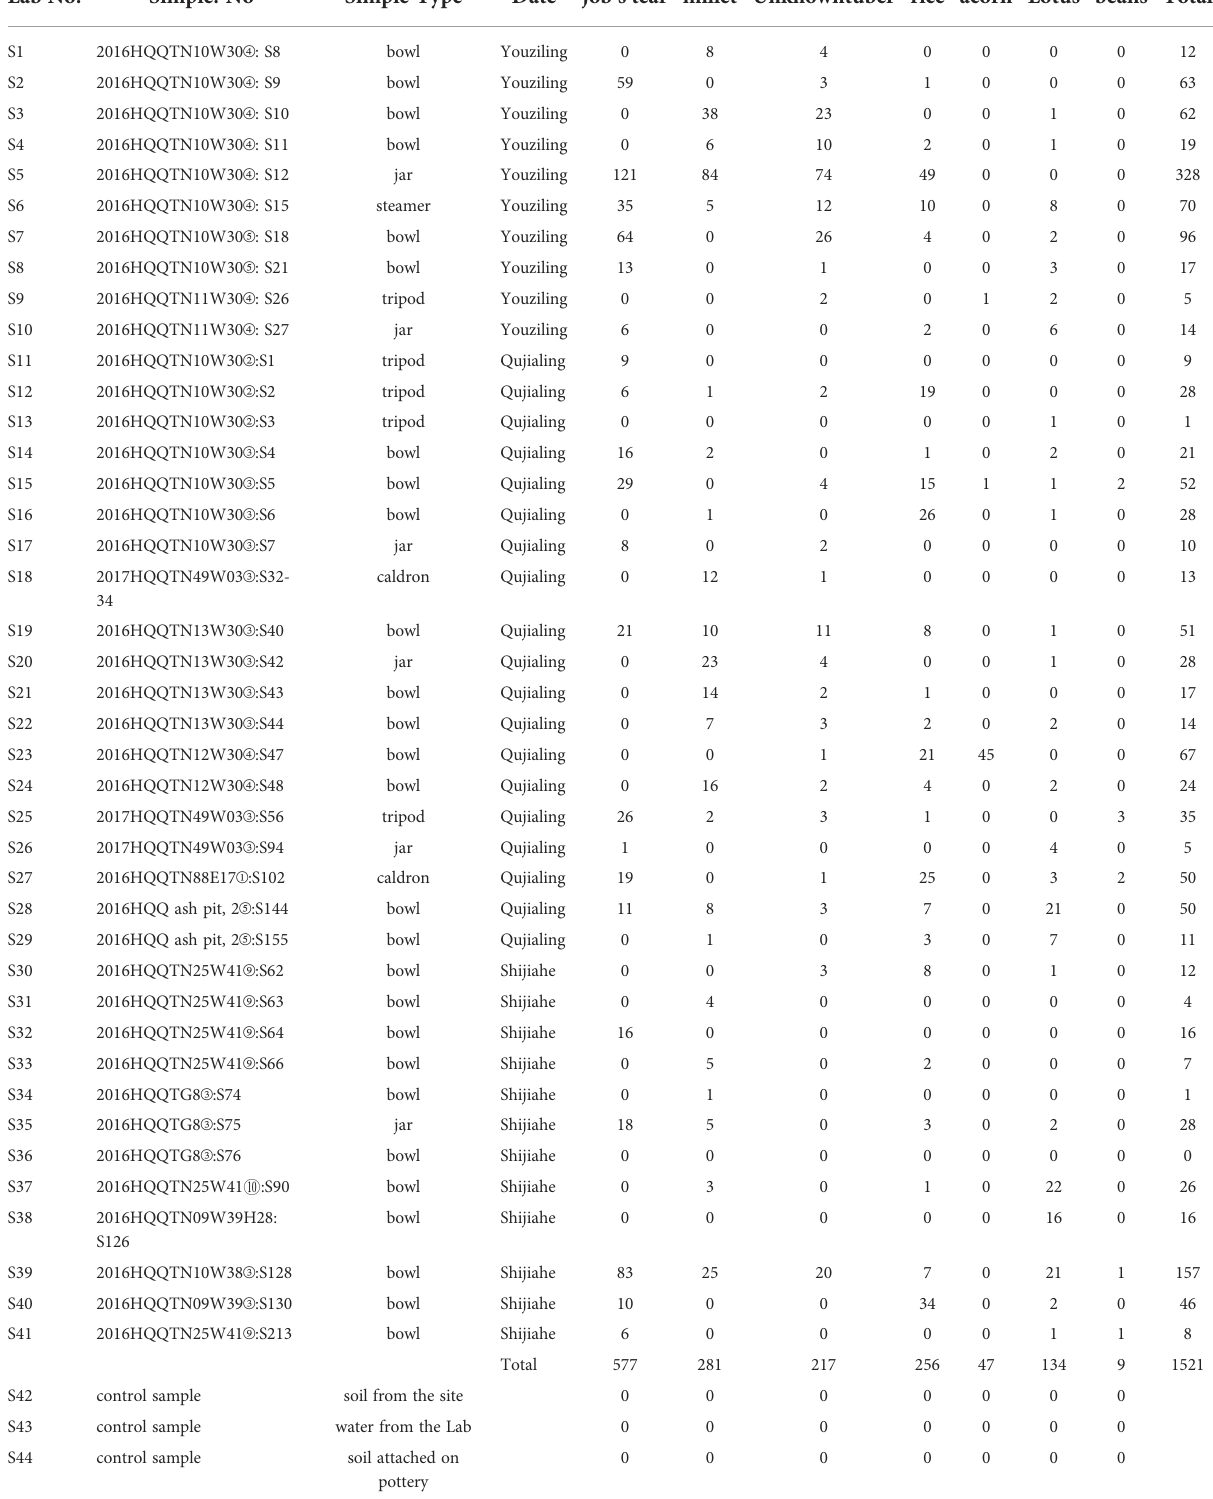
TABLE 1 Information of the studies pottery samples and the identi fi ed starch grains on the analyzed pottery sherds in the present study. Lab